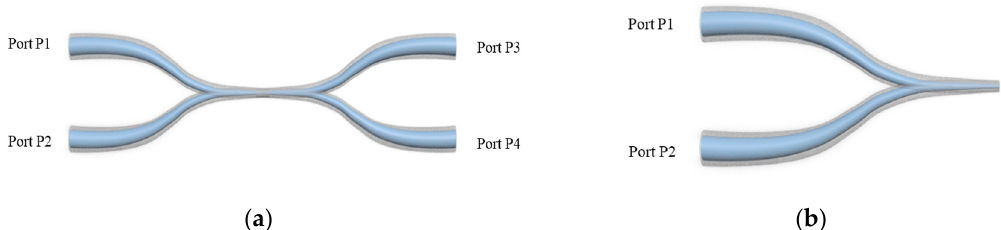
Figure 18. Schematic of ( a ) a MFC structure and ( b ) a MFCT structure.